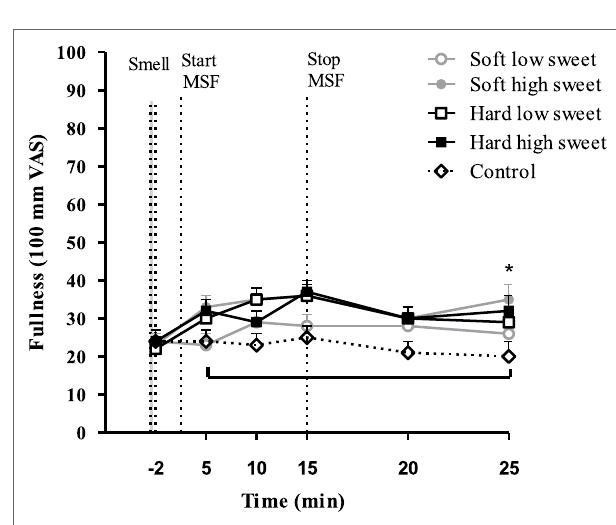
FigUre 11 | Estimated mean ± SEM fullness changes over time per treatment and control condition. Significant differences were found between treatments and control indicated by the bracket ( p < 0.05). *Significant taste effect ( p = 0.04).